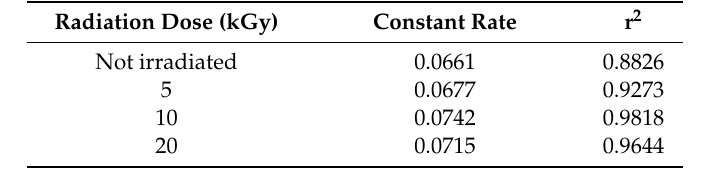
Figure 8. DB1 linear adjustment according to pseudo first order kinetics, data from Figure 7. Table 2. Rate constants for pseudo first order reaction at different irradiation doses.